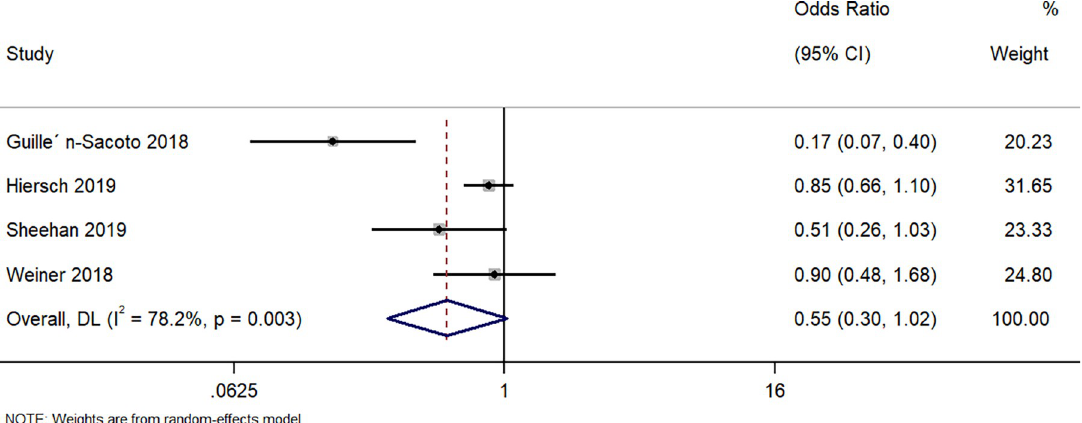
Fig 8. Forest plot showing the difference in neonatal hypoglycaemia between women with a singleton pregnancy or twin pregnancy and GDM. NOTE: Weights are from random-effects model.